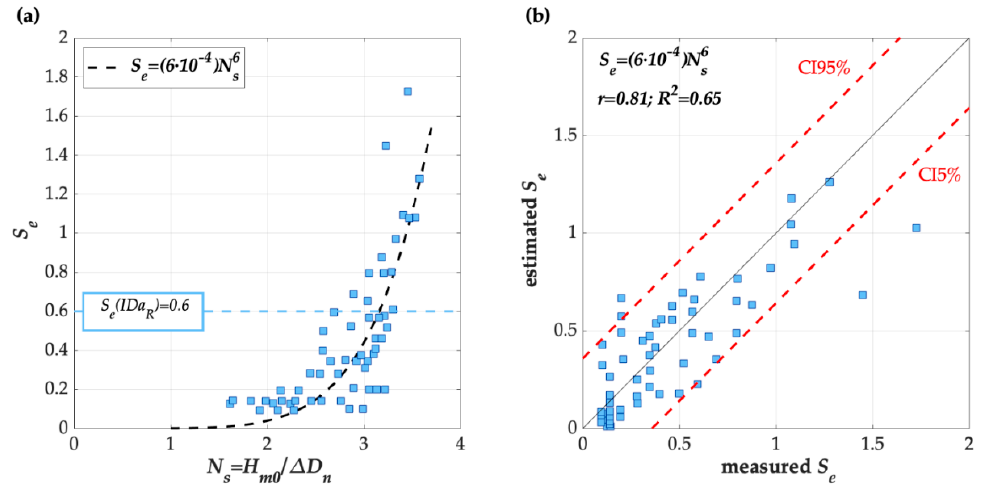
Figure 10. Performance of Equation (14) with K 1 = 6·10 − 4 and K 2 = 6 to estimate armor damage to the rear slope of the cube- armored model: ( a ) Fitting to the measured data and IDa level, and ( b ) measured against estimated S e